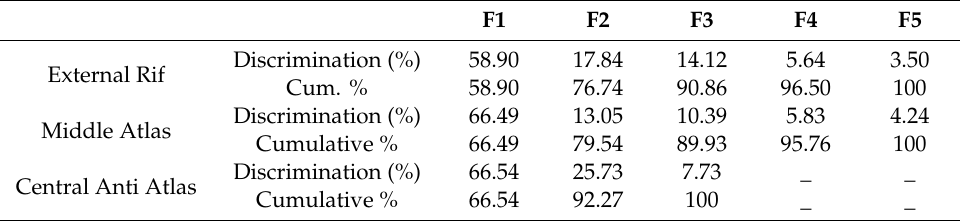
Table 7. Discriminant functions and their percentage of classifications for each sector.